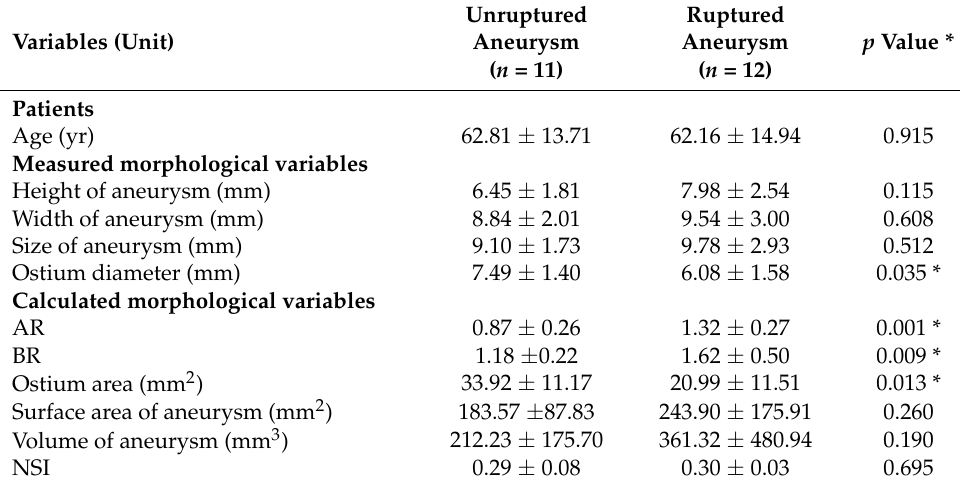
Table 2. Quantification of morphological